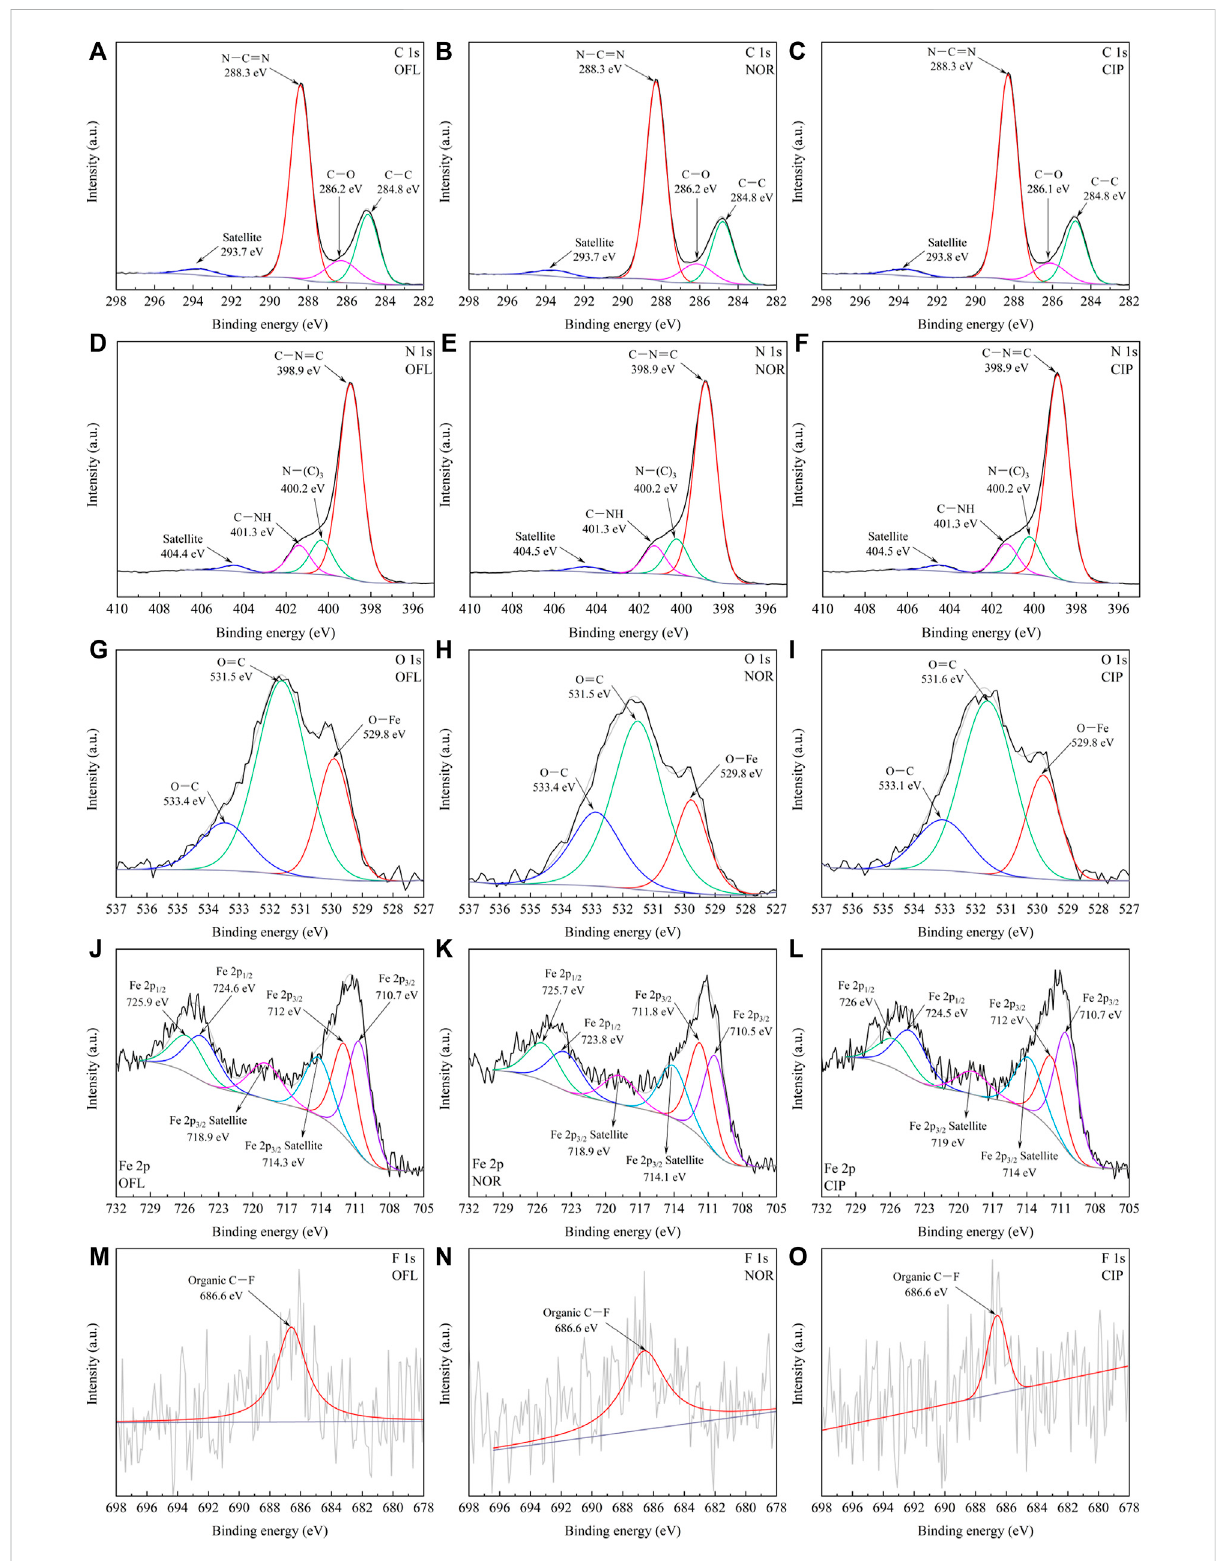
FIGURE 8 XPS spectra of 10% IGCN after the reaction, (A – C) C 1s, (D – F) N 1s, (G – I) O 1s, (J – L) Fe 2p, and (M – O) F